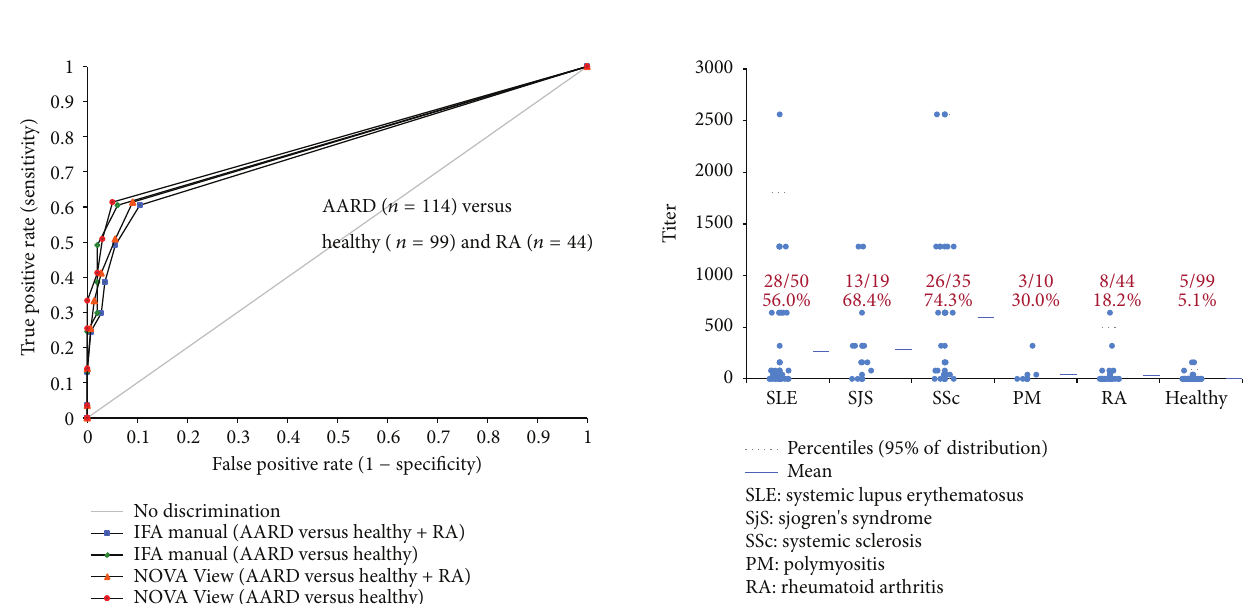
Figure 2: Agreement and correlation between manual and NOVA View archived image based reading. (a) Receiver operating characteristic (ROC) analysis. Results of the manual indirect immunofluorescence interpretation were grouped into positive and negative. Subsequently, the titers obtained from the NOVA View interpretation were used to generate a ROC curve showing very good agreement ( 𝑛 = 369 ). (b) Spearman’s correlation (all samples, 𝑛 = 369 ) between manual indirect immunofluorescence interpretation and NOVA View. Excellent correlation of rho = 0.96 was found.